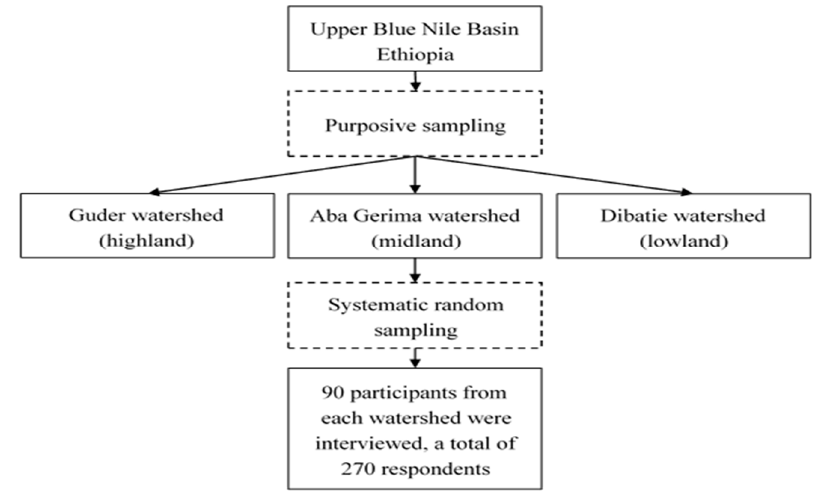
Figure 2. Sampling flowchart.